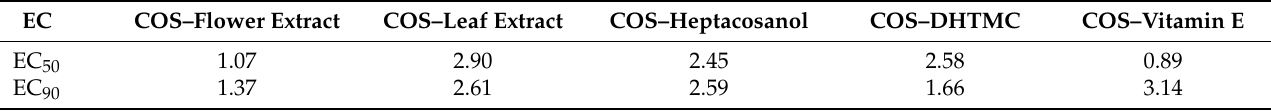
Table 7. Synergy factors, estimated according to Wadley’s method, for the conjugate complexes under study.